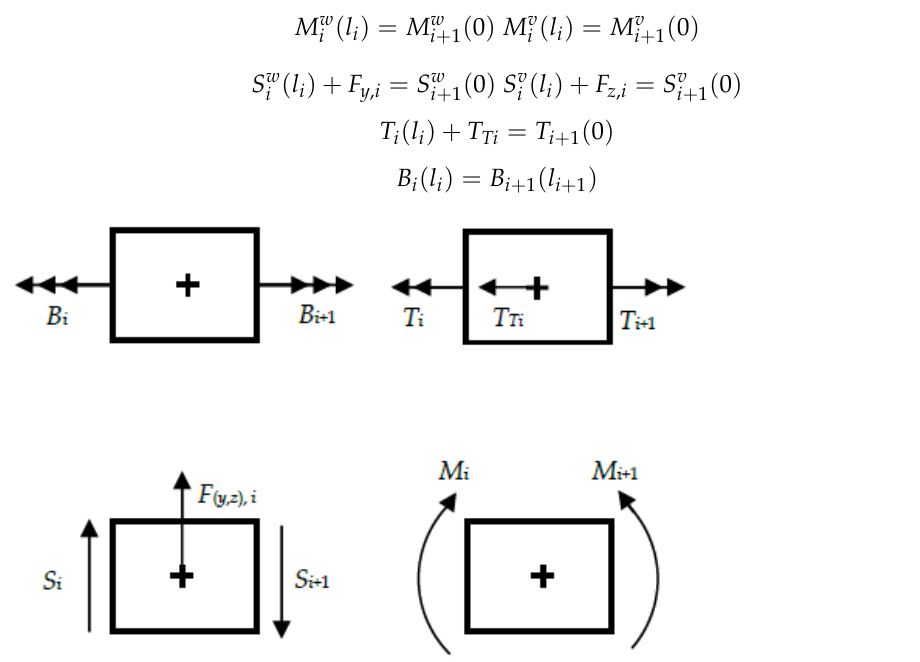
Figure 3. The force equilibrium conditions at the interface.